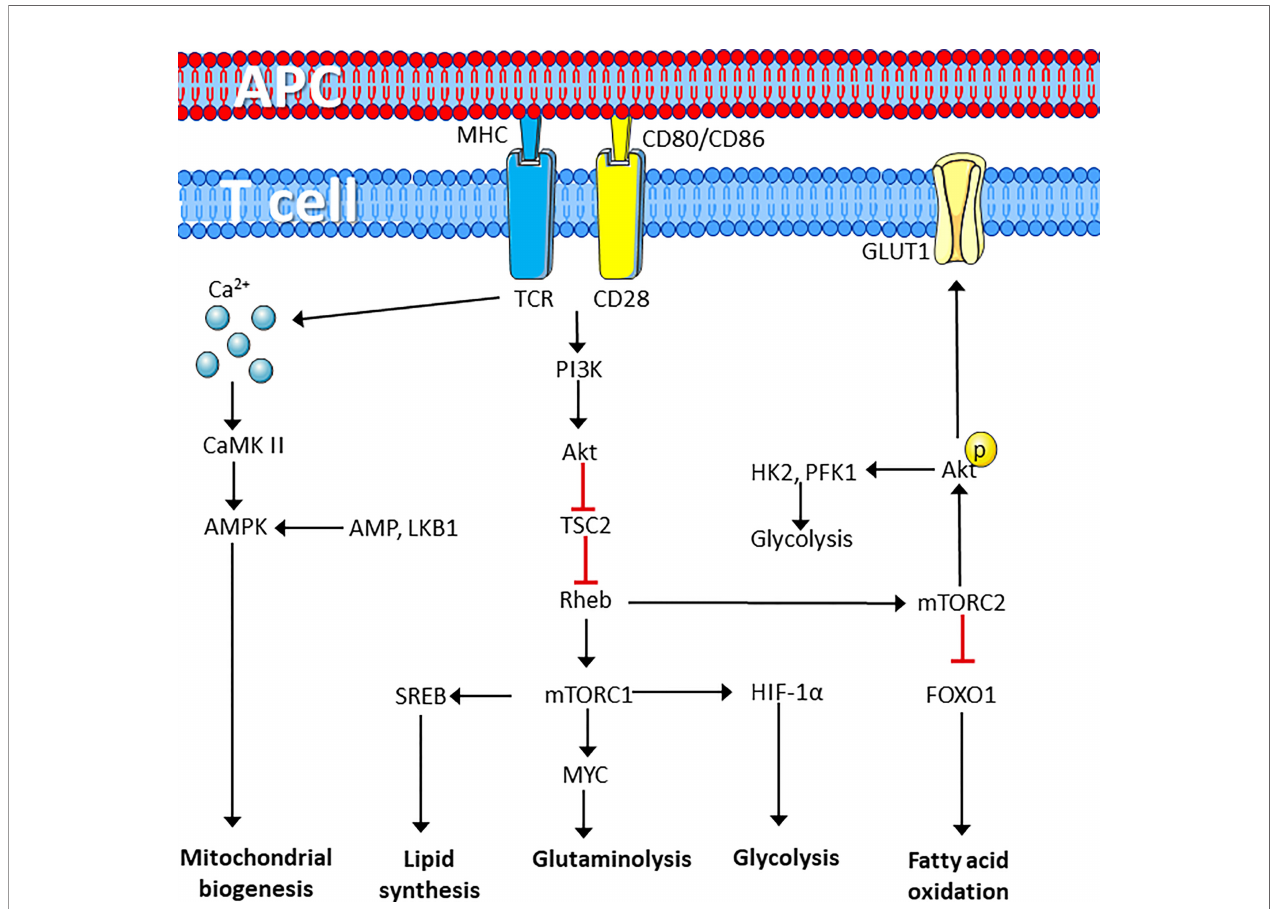
FIGURE 1 | T cell receptor perturbation drives metabolic reprograming. T cell activation by ligation of the TCR and CD28 cell surface marker induces metabolic reprograming through activation of protein kinases that induces calcium dependent activation of the AMPK pathway to induce synthesis of mitochondria. In addition, mTORC1 activation induces lipid synthesis and enhances lipid synthesis, glutaminolysis and glycolysis required for rapid proliferation, whereas mTORC2 induces glucose uptake and glycolysis while repressing fatty acid oxidation. Figure was created using assets from Servier Medical Art, licensed under a Creative Common Attribution 3.0 Generic License. (http://smart.servier.com/). APC, antigen presenting cell; TCR, T cell receptor; PI3K, phosphatidylinositol kinase 3; CaMK II, calcium calmodulin-dependent kinase II; AMPK, adenosine monophosphate-dependent kinase; TSC2, tuberous sclerosis complex 2; Rheb, RAS homolog enriched in the brain; LKB1, liver kinase B1; SREB, sterol regulatory element-binding proteins; HIF-1 a , hypoxia-inducible factor 1 a ; mTORC, Mechanistic target of rapamycin complex; GLUT1, Glucose transporter 1; FOXO1, forkhead box O1; FAO, fatty acid oxidation; HK1, hexokinase 1; PFK-1, phosphofructokinase